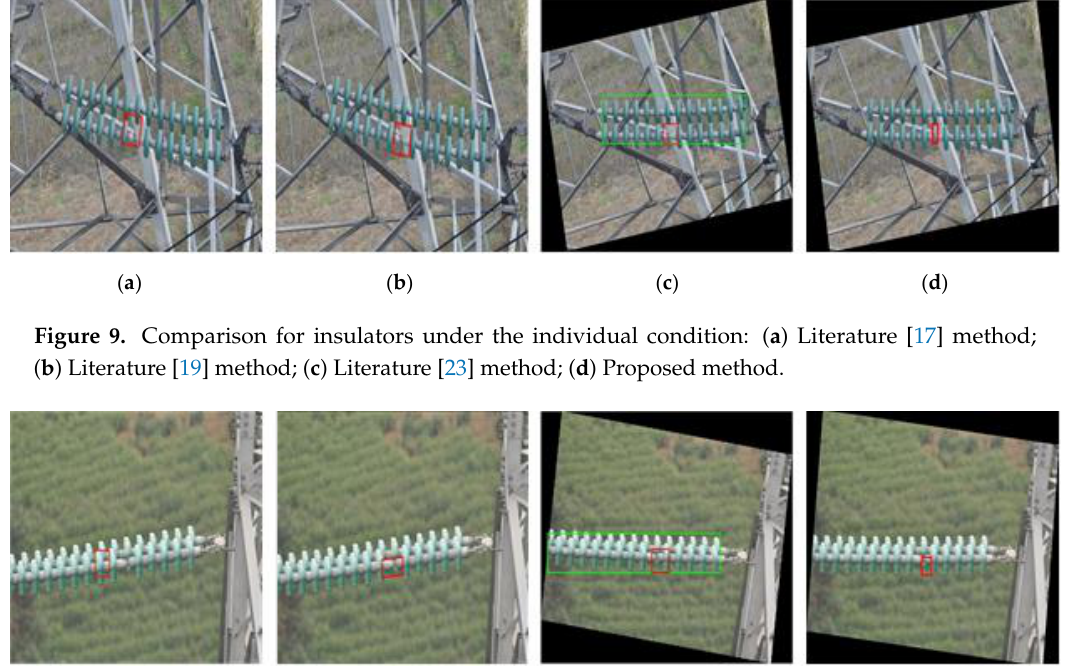
Figure 10. Comparison for insulators under the obstructed condition: (a) Literature [17] method; (b) Literature [19] method; (c) Literature [23] method; ( d ) Proposed method.